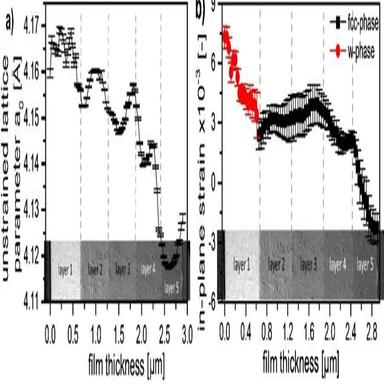
Evolution of a) the unstrained lattice parameter and b) the in-plain strain as a function of the thickness of the graded TiAl(O)N film, both superimposing the nitrogen jump ratio image.